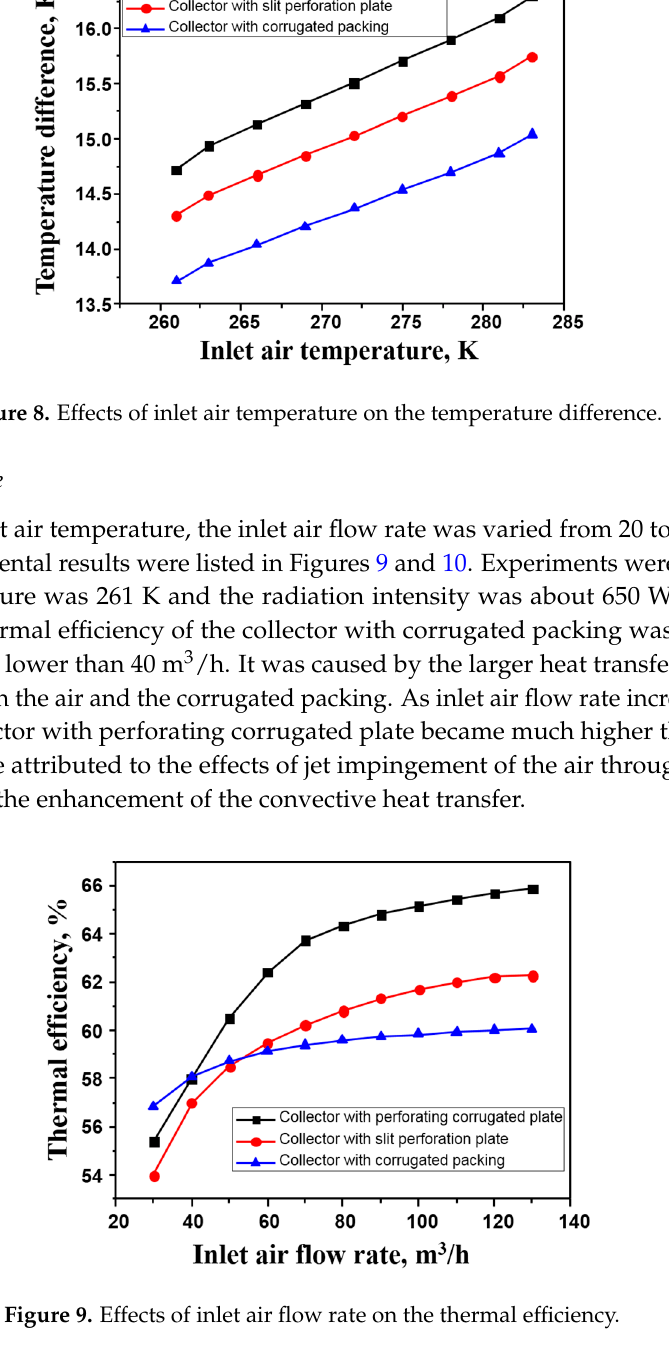
Figure 7. Effects of inlet air temperature on the thermal efficiency.